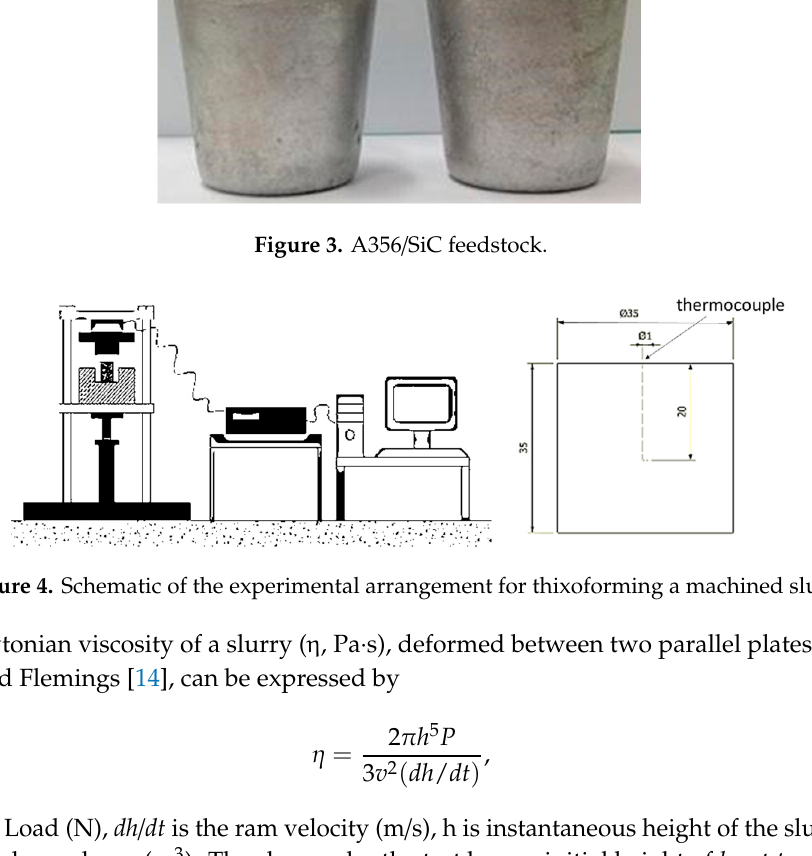
Figure 4. Schematic of the experimental arrangement for thixoforming a machined slug .